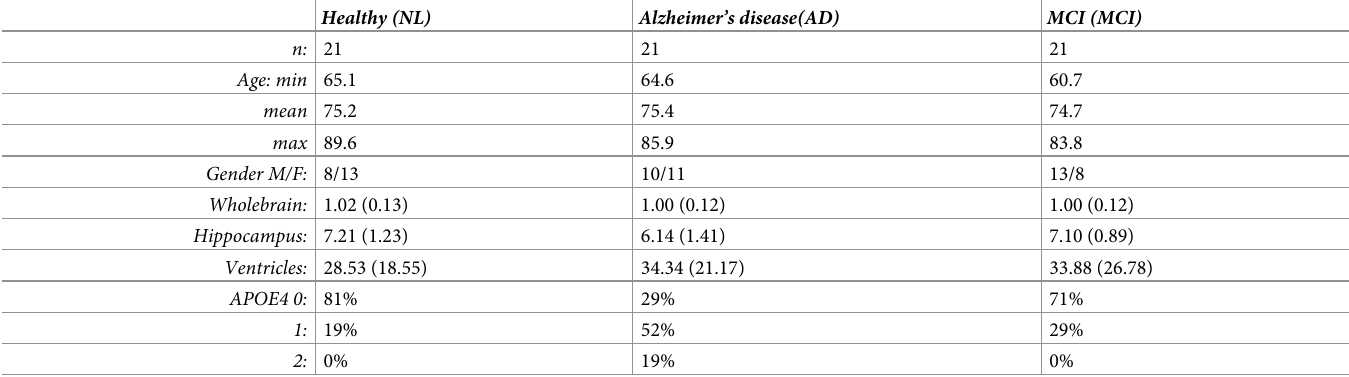
Table 1. Demographic, physical and genetic characteristics for the training data. The variables shown are the sample size n , age, gender, scaled medians(iqr) of MRI vol- ume measurements at baseline, and APOE4 status. In the AD set, 19 participants transition from MCI, while 2 participants transition from a healthy diagnosis.